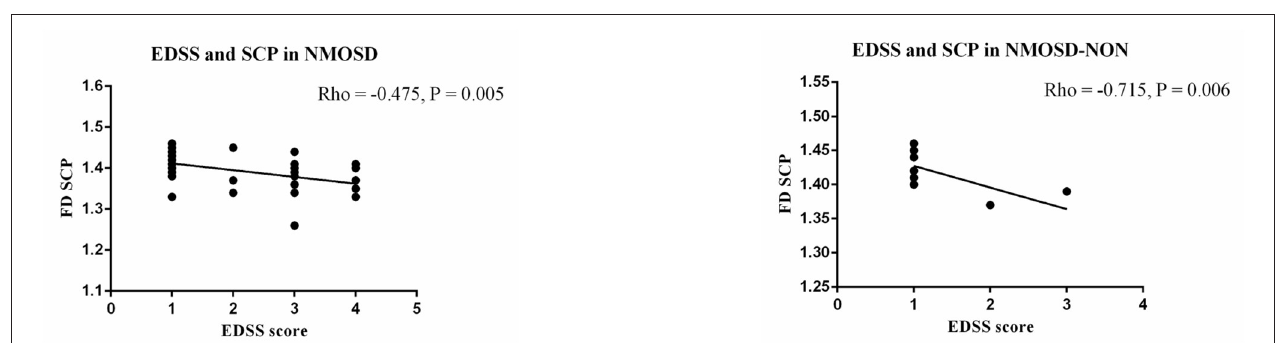
FIGURE 3 | Correlation between expanded disability scale status (EDSS) and macula FD in NMOSD patients.